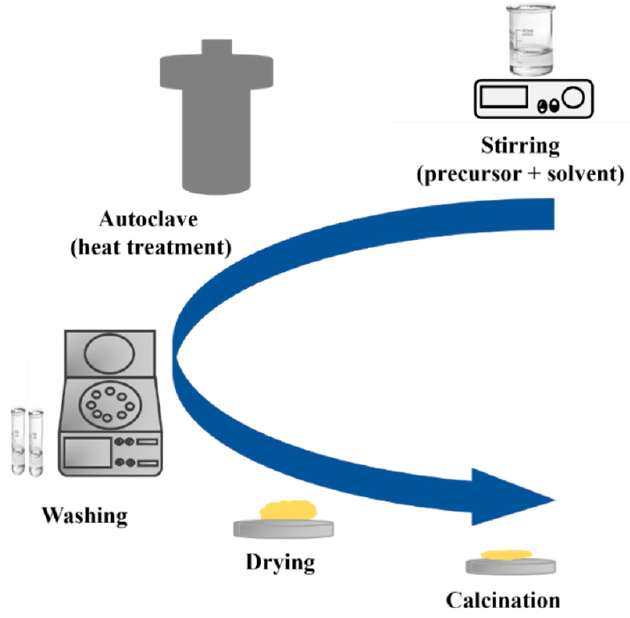
Figure 20. Schematic diagram of a hydrothermal method.